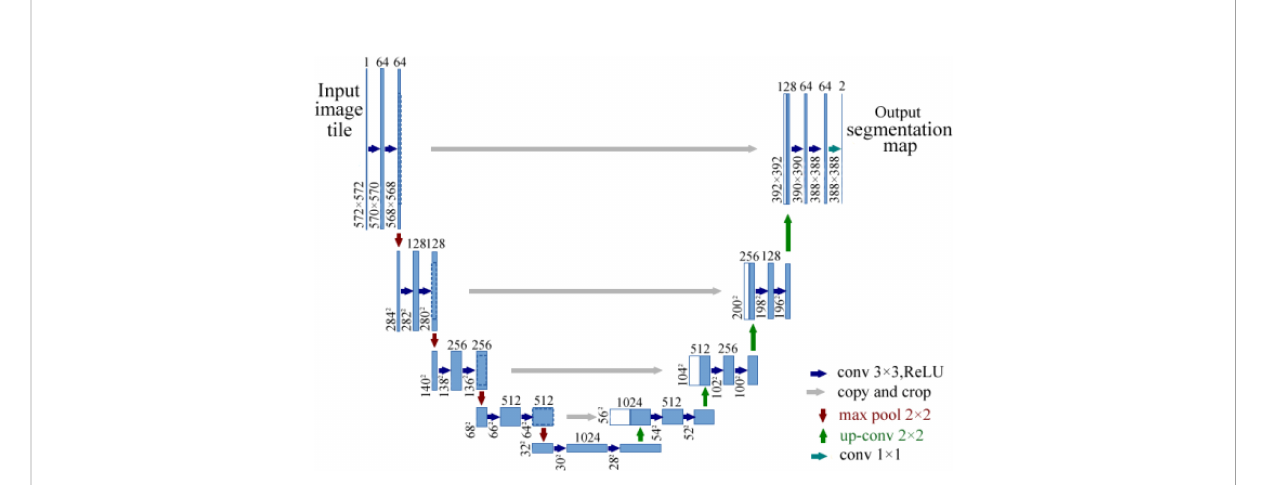
FIGURE 8 Architecture of U-Net for semantic segmentation (48). The model consists of a contracting path and an expansive path.